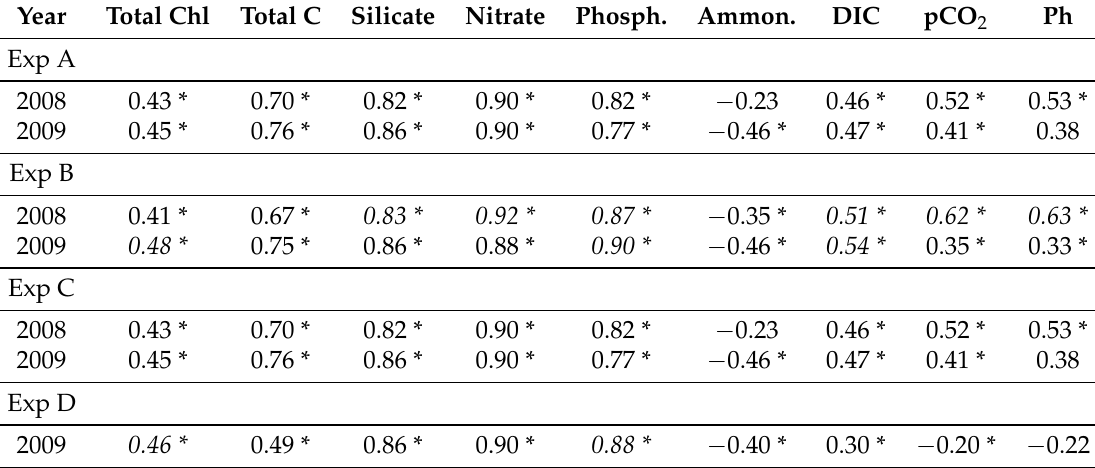
Table 1. Pearson correlations for simulation experiments A–D, between observed and modeled variables for 2008 and 2009 at the shallowest depth available. Significant correlations at the 95% are indicated by *. Values in italic signify an improvement with respect to Experiment